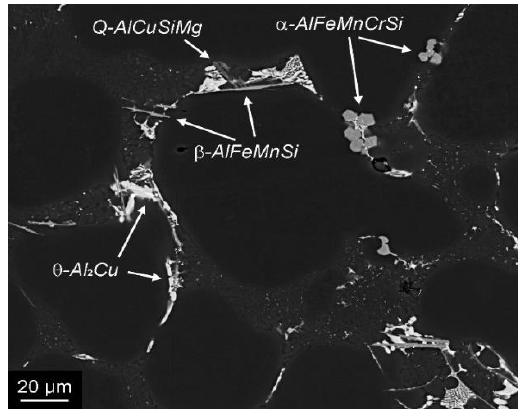
Figure 5. Scanning electron microscopy micrograph of as-rheocast alloy.